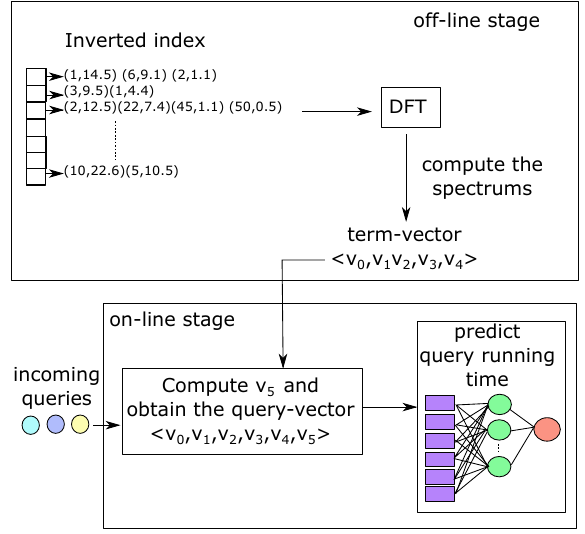
Figure 4. Scheme of the DFT-based query running time prediction